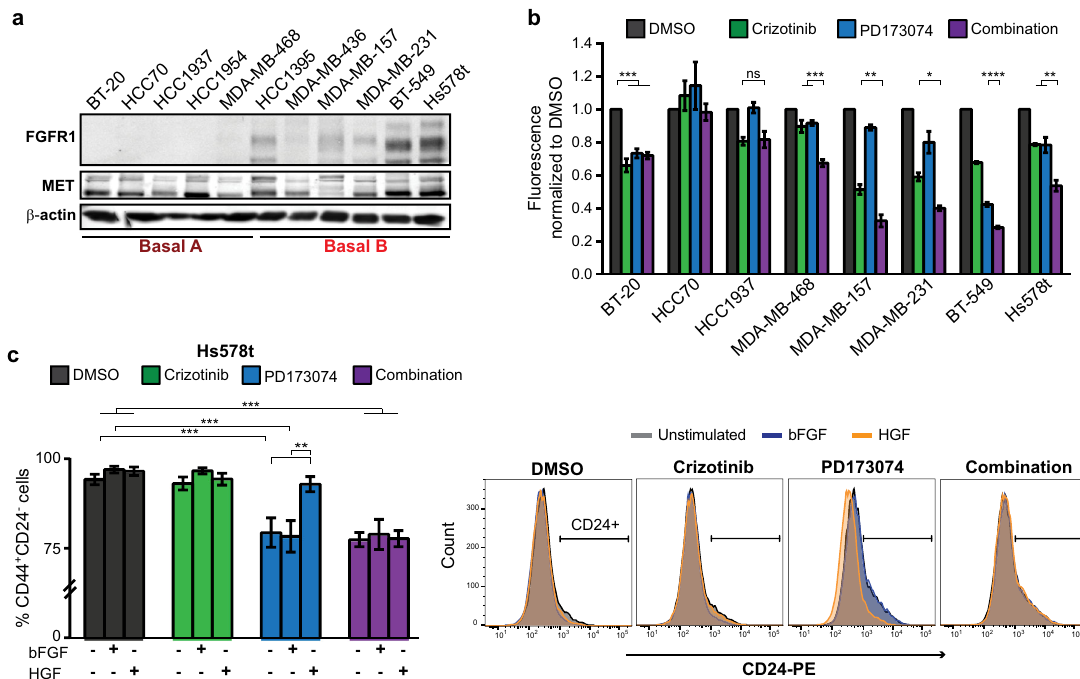
Fig. 6 Co-inhibition of MET and FGFR signalling targets TICs in basal B breast cancer cell lines. a Western blot analysis was performed to validate MET and FGFR1 protein levels across a panel of TNBC cell lines ( n = 3). b The indicated TNBC cell lines, comprised of a mix of basal A and basal B cell lines, were cultured as tumourspheres in the presence of HGF (50 ng/ml) and bFGF (20 ng/ml) and treated with 1 μ M Crizotinib and/or 1 μ M PD173074. Tumoursphere proliferation was detected by Cyquant proliferation assay ( n = 3). c Hs578t cells were treated with Crizotinib and/or PD173074 for 2 h, followed by 30 min stimulation with HGF or bFGF. The proportion of CD44 + CD24 - cells was determined by fl ow cytometry 72 h later ( n = 3). Student ’ s t test; * P ≤ 0.05; ** P ≤ 0.01; *** P ≤ 0.001; **** P ≤ 0.0001. Error bars indicate